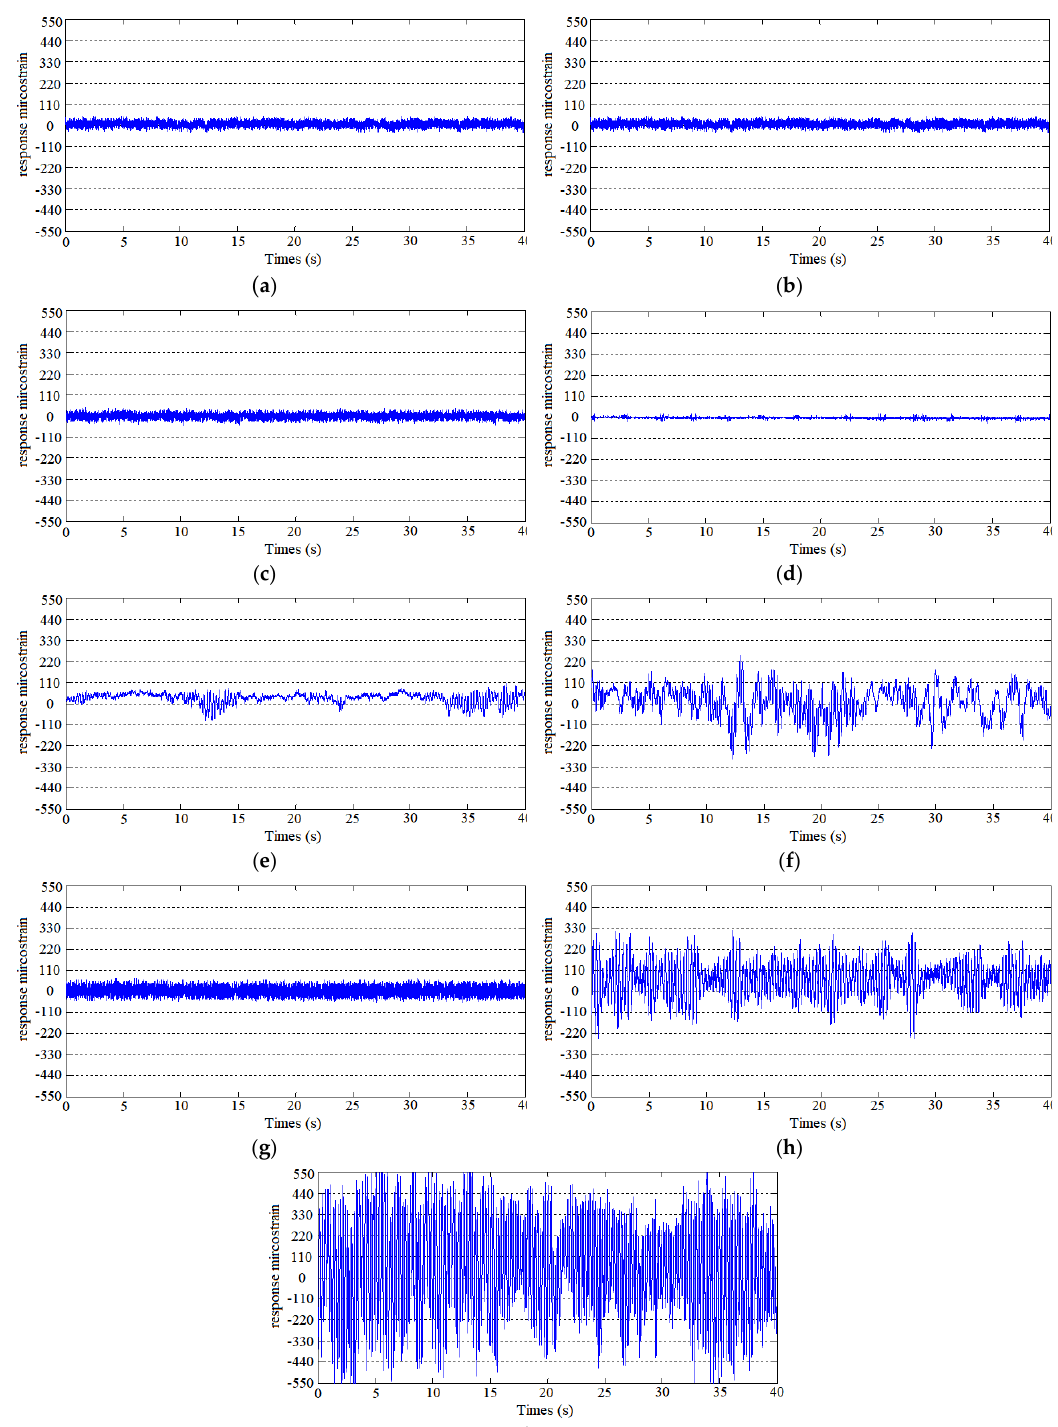
Figure 4. Response microstrain curves of the three risers at z = 0.5 m with 5 N top tension force and S-S end condition. ( a ) 0.2 m/s, Al, case 1; ( b ) 0.6 m/s, Al, case 2; ( c ) 1.0 m/s, Al, case 3; ( d ) 0.2 m/s, PMMA, case 13; ( e ) 0.6 m/s, PMMA, case 14; ( f ) 1.0 m/s, PMMA, case 15; ( g ) 0.2 m/s, UPVC, case 25; ( h ) 0.6 m/s, UPVC, case 26; ( i ) 1.0 m/s, UPVC, case 33.